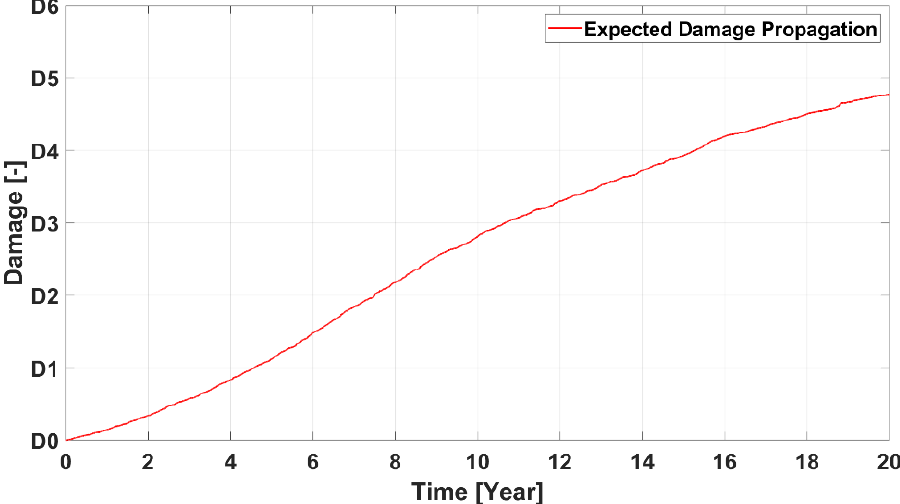
Figure 5. The expected damage propagation.